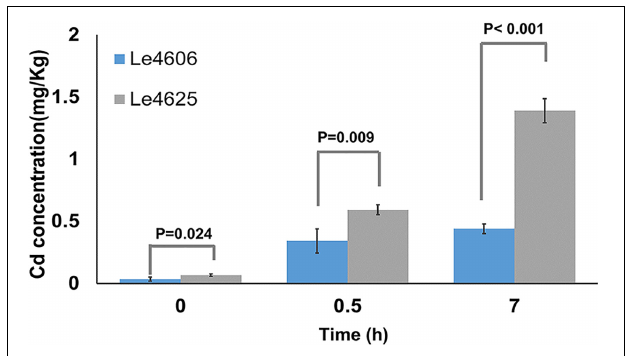
FIGURE 1 | Cd concentrations in L.edodes genotypes Le4606 and Le4625 after exposure to Cd (0.1 mg/L) for 0, 0.5, and 7